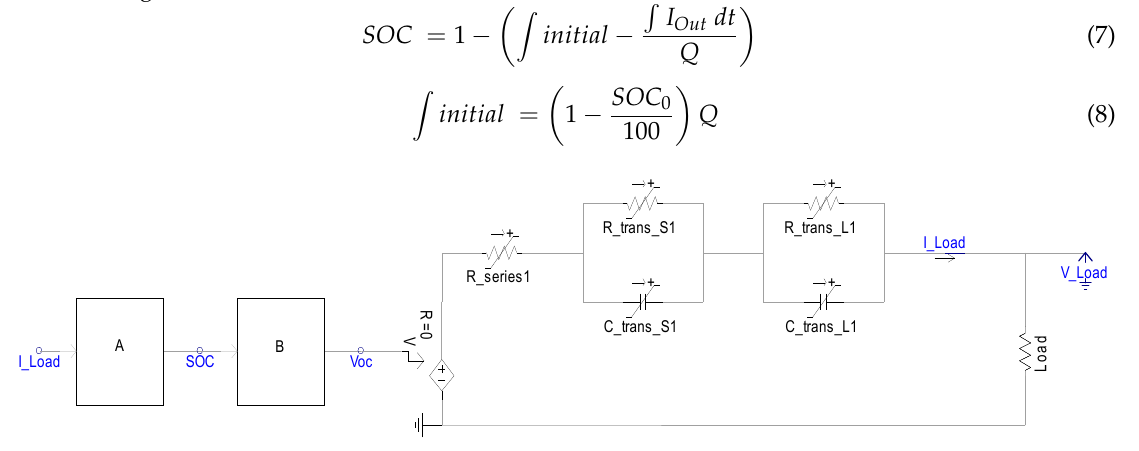
Figure 7. Simulation model. Table 1. Important characteristics of batteries well recognized for energy applications.